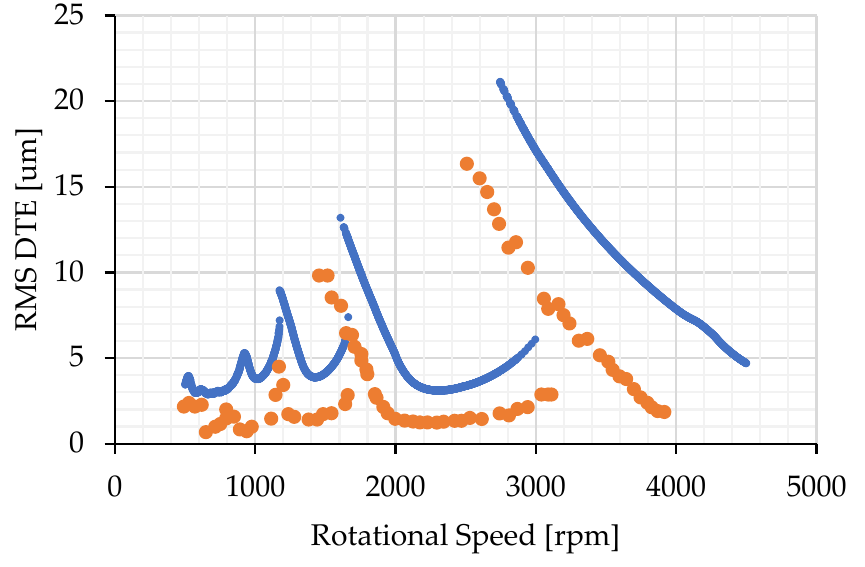
Table 1. Test gear parameters used in Refs. [17,23].